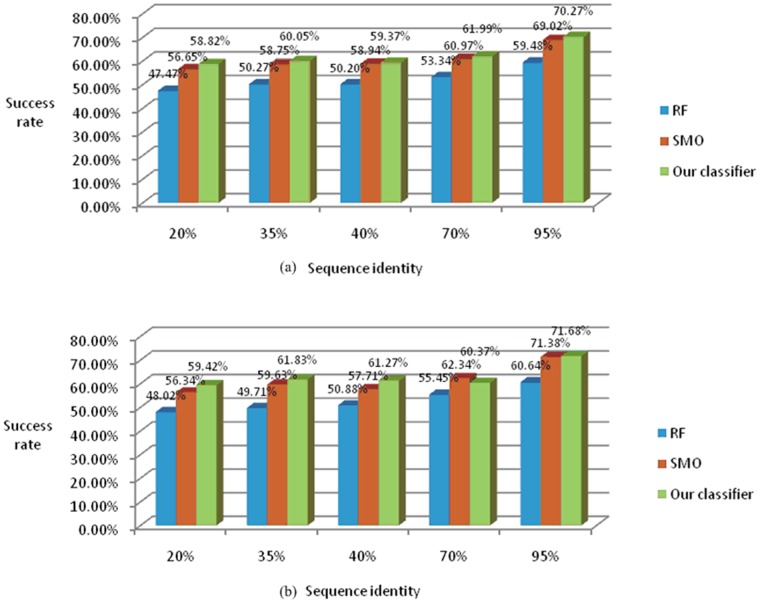
Success rate achieved by three classifiers with different sequence identity.The two graphs show the results of two datasets((a) SCOP version 1.75, (b) SCOP version 1.75A). Their similar success rates demonstrate the robustness of our model. As identity increases it becomes less stringent and success rate rises. It also shows our ensemble classifier outperforms other two classifiers.